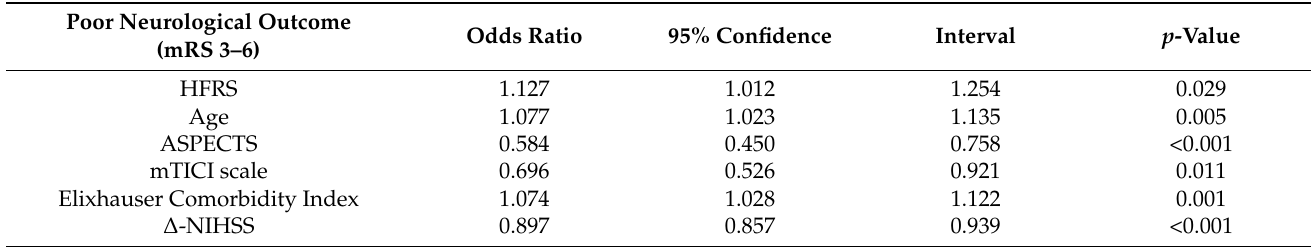
Table 6. Multivariate logistic regression analysis of neurological outcome after 90 days measured by mRS. Poor Neurological Outcome